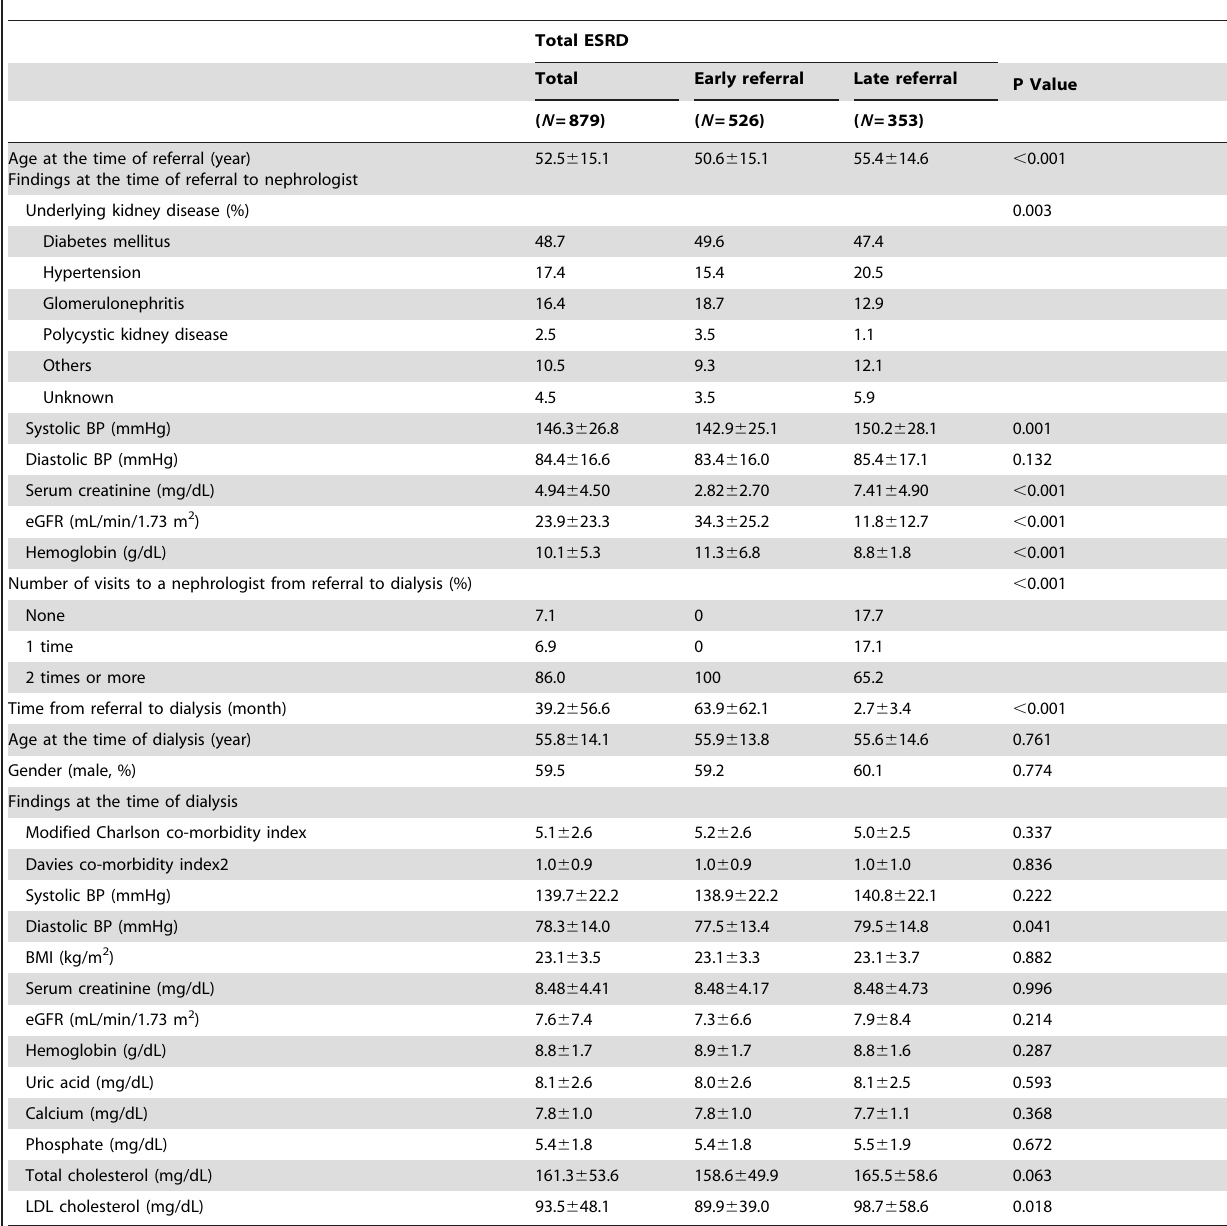
Table 1. Patient characteristics by referral pattern at the time of referral and dialysis